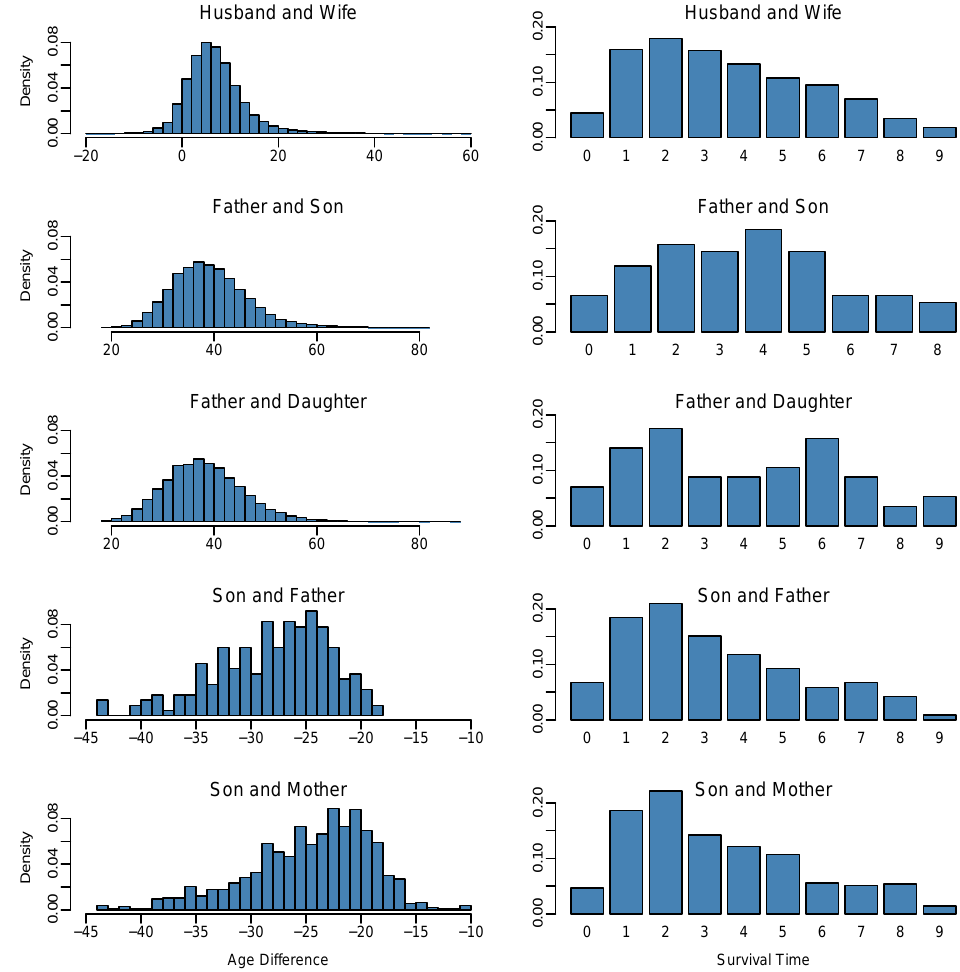
Figure 1. Age difference and survival time distributions for all samples. Table 3. Empirical dependence measures for each of the five samples, split by age difference d